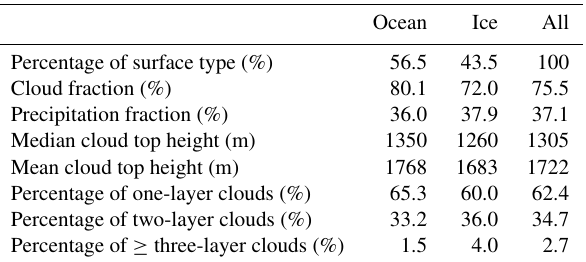
Table 5. Properties of clouds detected above ocean, sea ice, and both surface types.